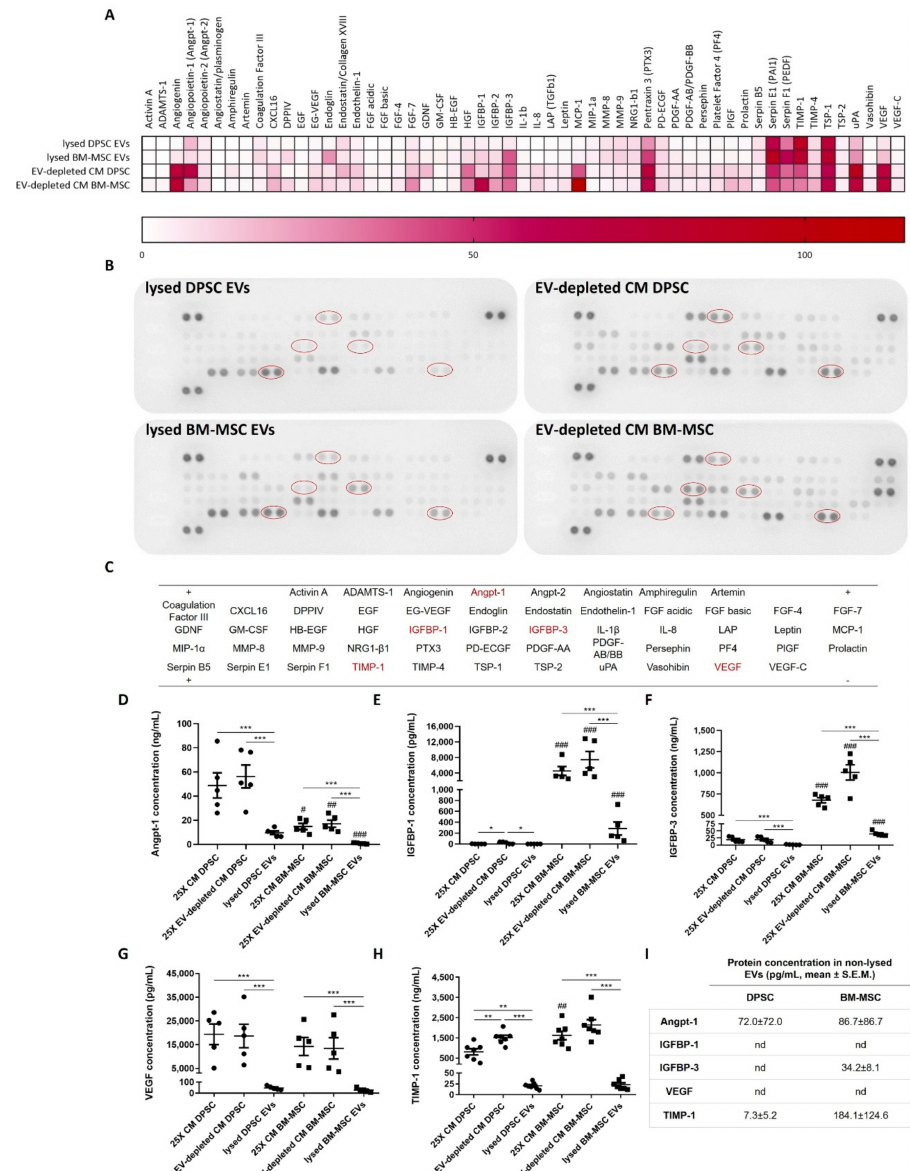
Figure 2. Angiogenic protein profiles of CM, EV-depleted CM, and lysed and non-lysed EVs of DPSCs and BM-MSCs. A screening for 55 pro- and anti-angiogenic factors was performed on EV-depleted CM and lysed EVs derived from DPSCs and BM-MSCs ( n = 3, 3 di ff erent donors). Relative pixel density was expressed as percentage after subtraction of the negative control and normalization to positive reference spots (indicated as ‘ − ’ and ‘ + ’) and displayed in a heat map ( A ). Representative antibody blots are presented for each condition ( B ), with the corresponding protein locations ( C ). Semi-quantitative results of proteins angiopoietin-1 (Angpt-1) ( D ), IGFBP-1 ( E ), IGFBP-3 ( F ), VEGF ( G ) ( n = 5, 5 di ff erent donors (DPSCs) or 5 di ff erent isolations of 3 di ff erent donors (BM-MSCs)) and TIMP-1 ( H ) ( n = 7,